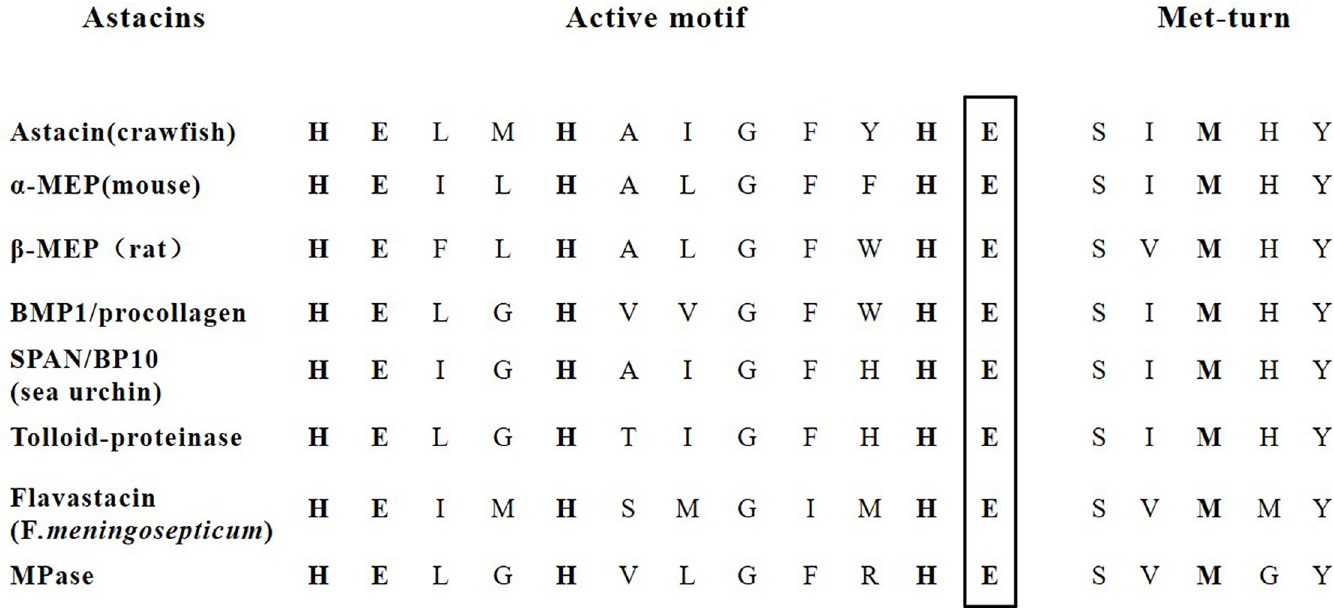
Fig 1. Marker conservative sequences of astacin-like metalloendopeptidases: The extended motif of the active site and Met turn.